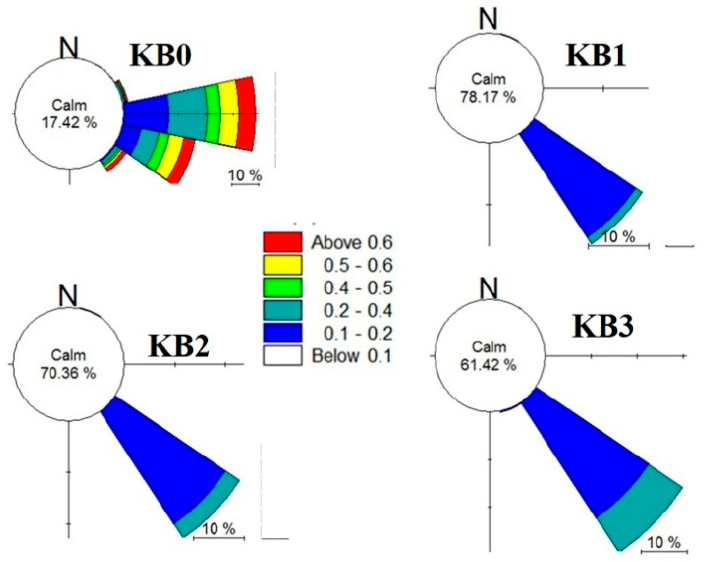
Figure 13. Wave rises at P5 for KB0, KB1, KB2, and KB3 scenarios in the NE monsoon (January 2014).